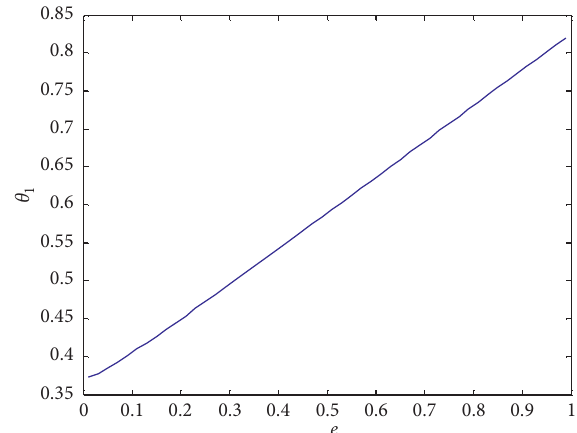
Figure 4: Relationship between loan amount applied by SMEs and CDS loss rate.